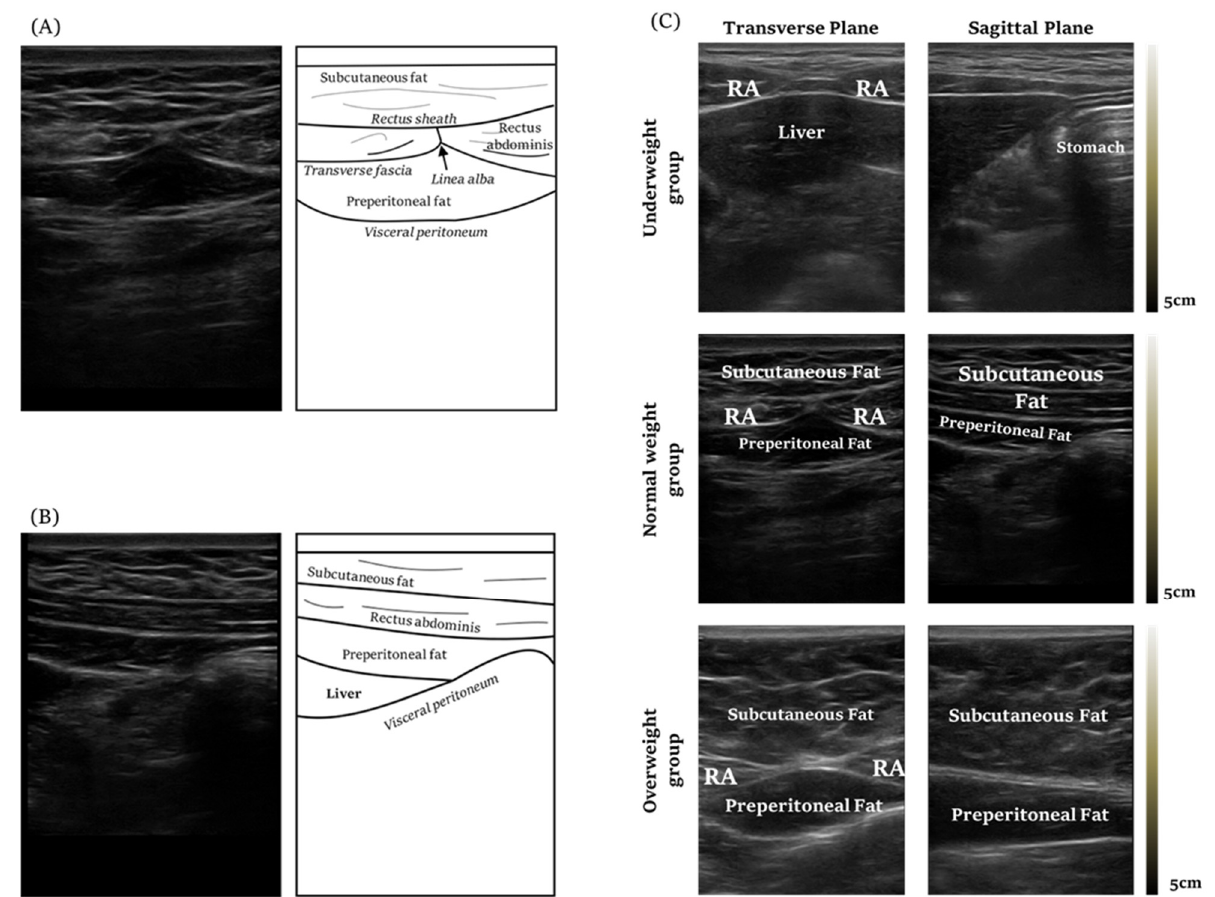
Figure 3. Ultrasound image of CV12 ( A ) Ultrasound image, transverse plane view of CV12. The rectus abdominis is seen beneath the subcutaneous fat. Underneath is the preperitoneal fat. The visceral peritoneum lies below the preperitoneal fat. ( B ) Ultrasound image, coronal view of CV12. ( C ) Ultrasound image of CV12 according to the body mass index.